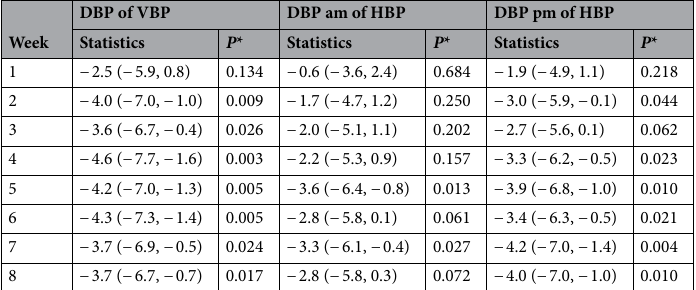
Table 4. Changes in morning DBP from baseline during intervention, mean (95% CI)*. * Adjusted for sex, age, body mass index , drinking, hypoglycemic agents, antihypertensive drug category and reduction of antihypertensive drugs in linear mixed